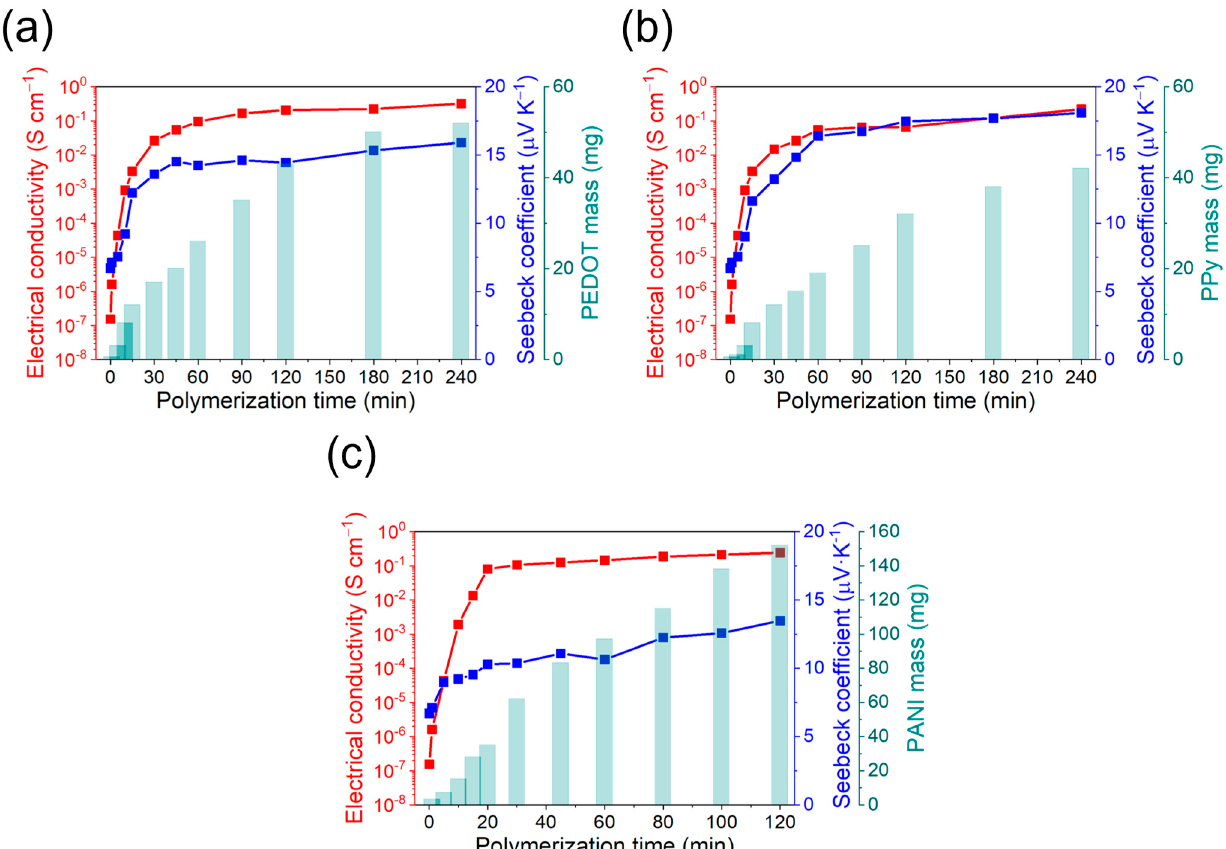
Figure 4. Electrical conductivity, Seebeck coefficient, and polymer mass deposition as a function of the polymerization time for: ( a ) PEDOT:ClO 4 , ( b ) PPy:ClO 4 , and ( c ) PANI:H 2 SO 4 .